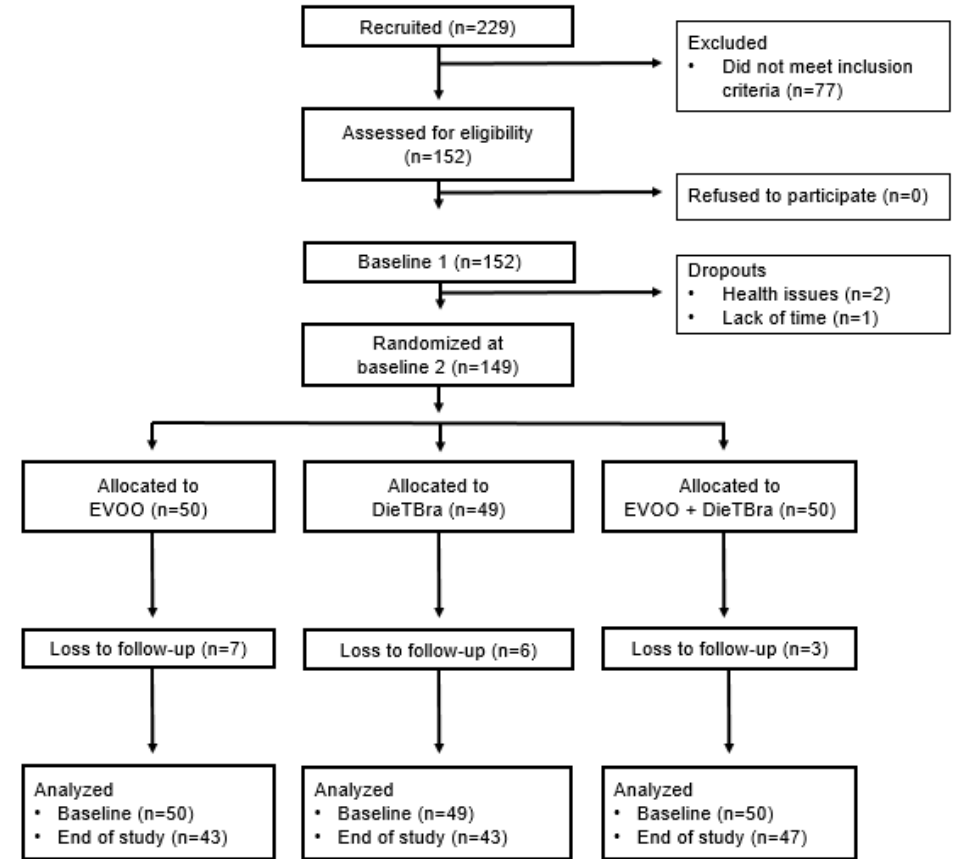
Figure 1. Flow diagram of enrollment, randomization, and follow-up. DieTBra: traditional Brazilian diet. EVOO: extra virgin olive oil ( n = 149).